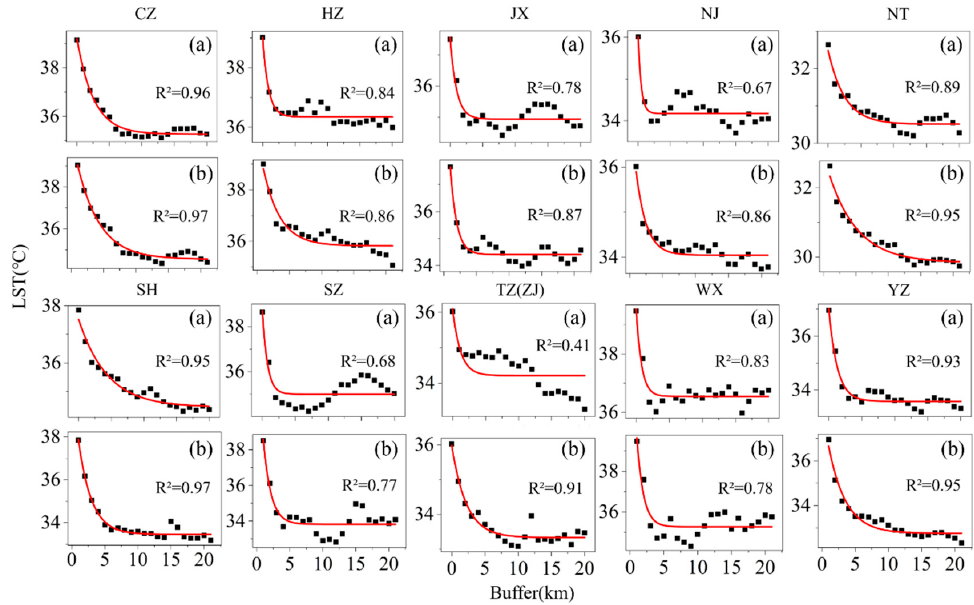
Figure 8. Land surface temperature fitting curves obtained by the rotational-scan exponential decay model and exponential decay model for the second category of cities. ( a ) Exponential decay model; ( b ) rotational-scan exponential decay model.